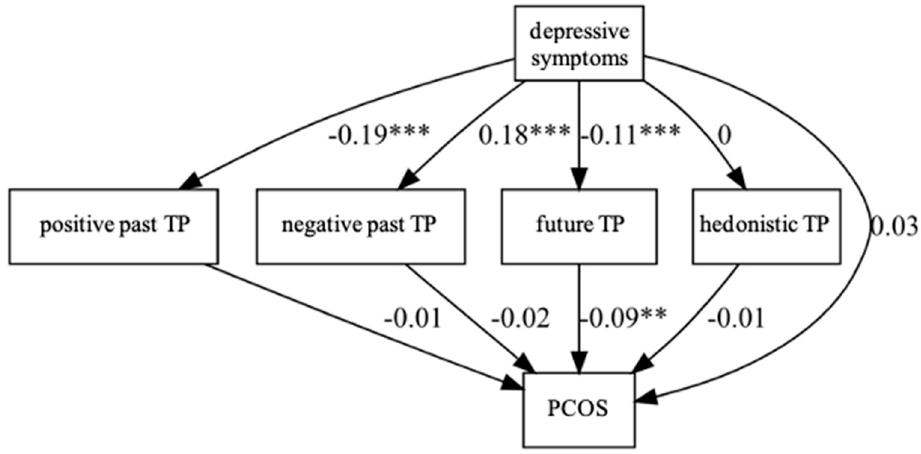
odds ratio; CI.L, confidence interval lower; CI.U, confidence interval upper.